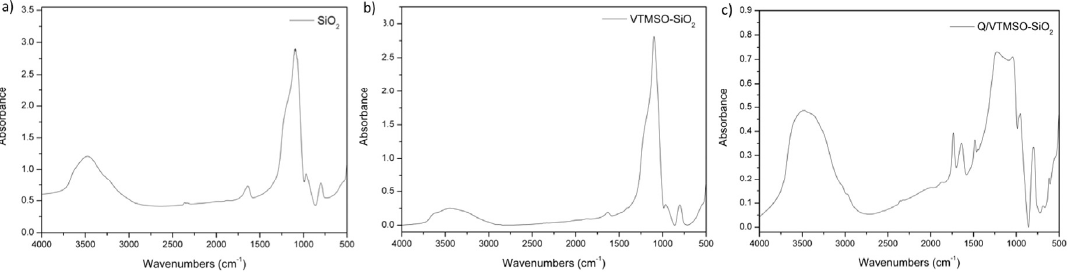
Figure 3. FT-IR spectrum of SiO 2 ( a ), VTMSO-SiO 2 ( b ), and Q/VTMSO-SiO 2 ( c ).